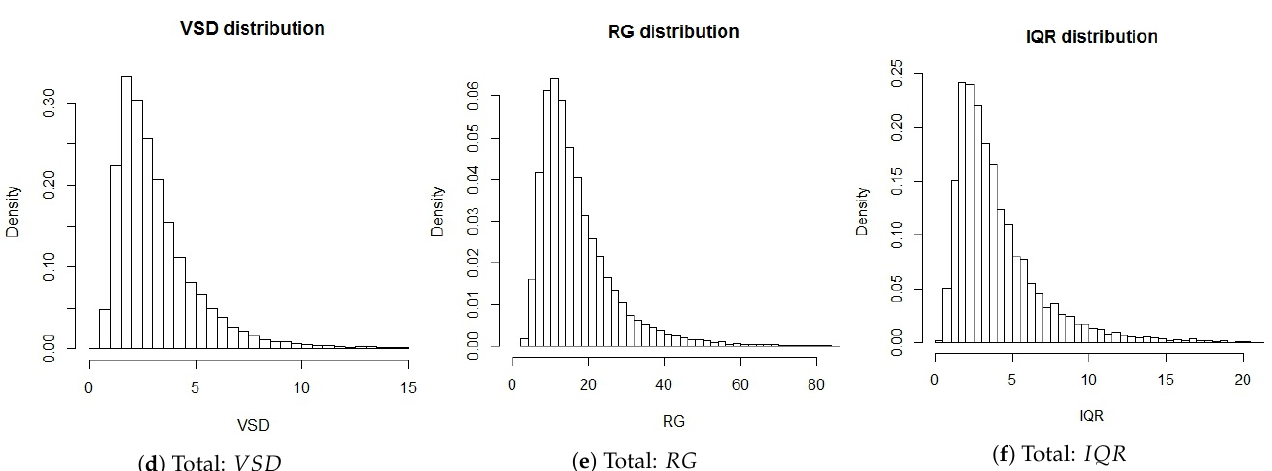
Figure 4. Histograms of all realized prices (subfigure ( a )) and the total five price fluctuation measures (subfigures ( b – f )). Extreme values at the tails of the distributions were omitted to provide